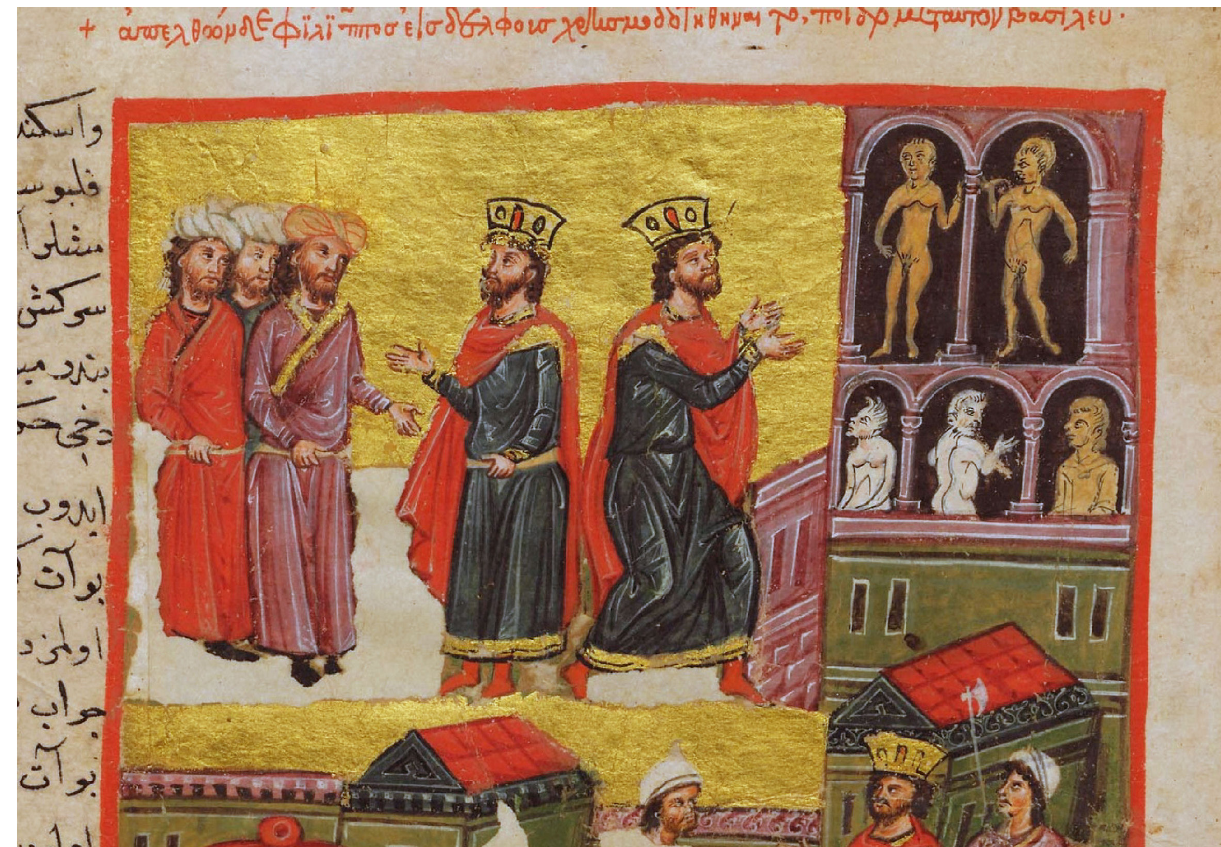
Figure 14. Venice. Istituto Ellenico di Studi Bizantini e Postbizantini cod. 5, fol. 16v (detail). Philip visits the Oracle of Delphi. Photo: ©Istituto Ellenico di Studi Bizantini e Postbizantini, Venice, all rights